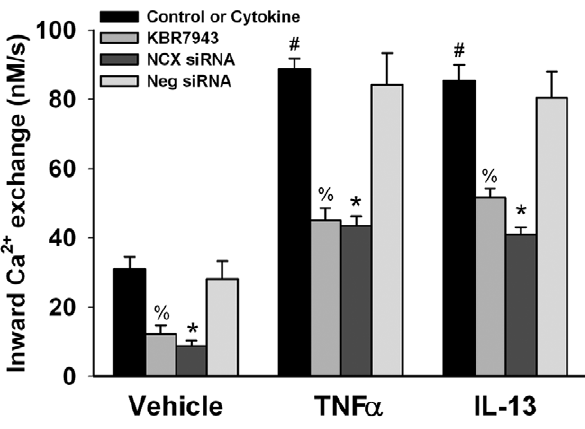
Figure 5. Effect of pro-inflammatory cytokines on inward Ca 2 + exchange via NCX in human ASM. In fura-2 loaded ASM cells where this mode of NCX was evaluated using the protocol illustrated in Figure 3, the NCX inhibitor KBR7943 significantly inhibited inward Ca 2 +